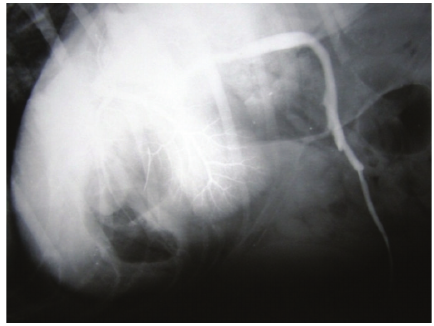
Figure 8: Normal-appearing hepatic angiogram, demonstrating jejunal mesenteric vein normally draining into the portal vein and the extensive portal vein branches in1-year-old male mixed-breed dog.